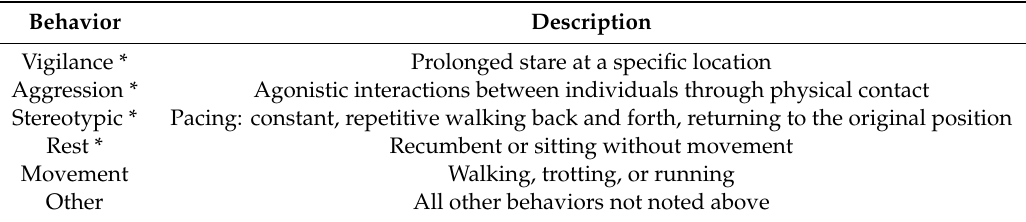
Table A2. Cheetah ethogram, with behaviors of focus indicated with an asterisk (*).